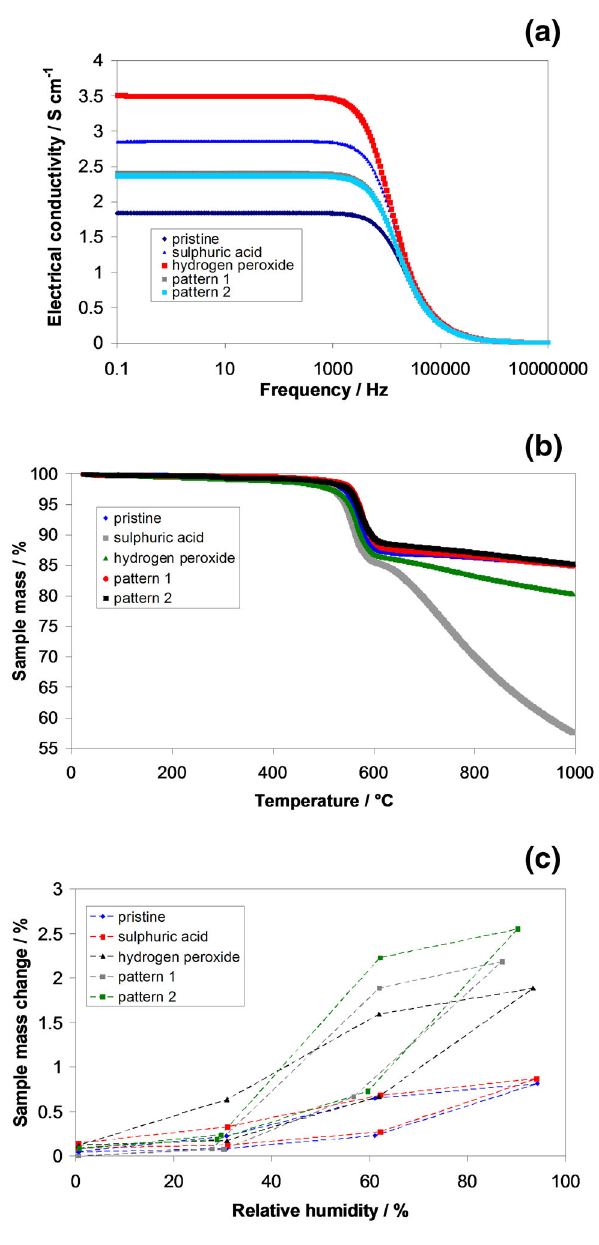
Fig. 5 a Electrical conductivity of pristine and chemically modified GDLs Sigracet 24BC, b the thermal stability (TGA measurement) of pristine and modified GDLs c water vapor sorption and desorption of investigated